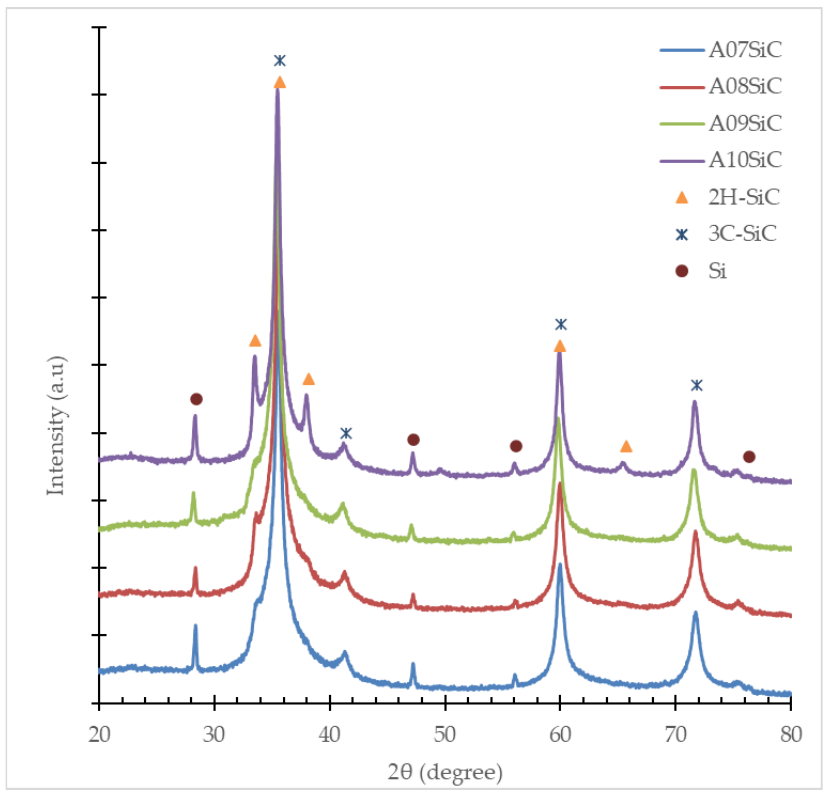
Figure 9. Diffraction pattern of the calcined product at 700 ◦ C in an air atmosphere after washing with a mixture of HF and CH 3 COOH solutions (based on rice husk char from carbonization at 700 to 1000 ◦ C).